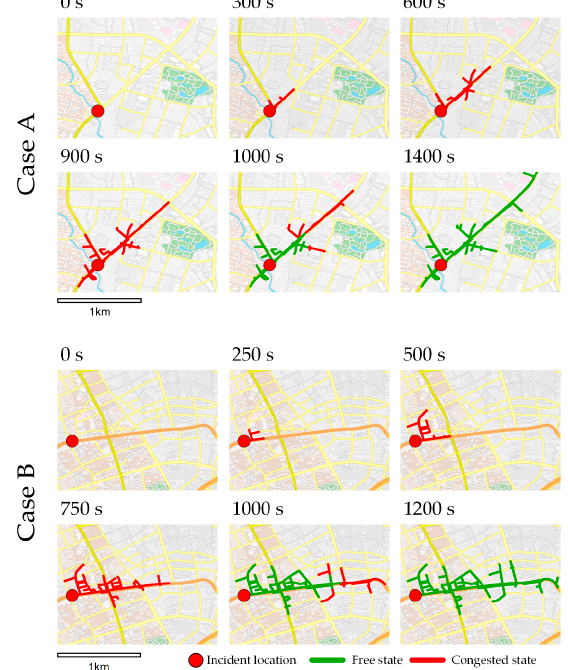
Figure 7. Spatiotemporal influence scope of two cases at different timestamps. The roads marked in red are congested, and the roads whose startup shockwave has already passed are free and marked in green.